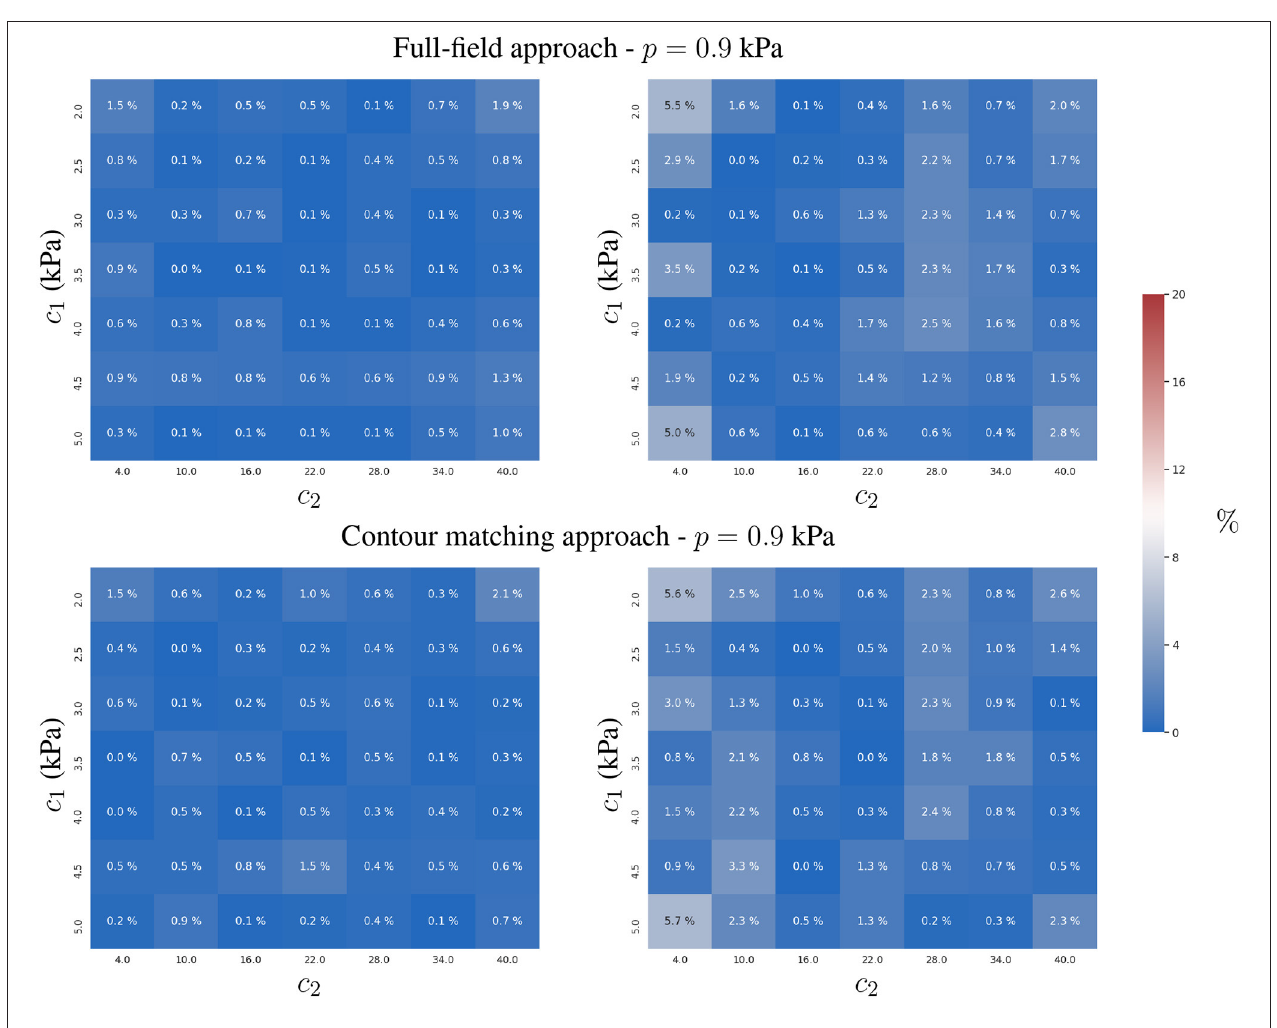
FIGURE 3 | Relative error of the two-parameter estimation. Estimates of the constitutive parameters c 1 (left) and c 2 (right) are presented using the full-field tracking and contour matching approaches with a load of p = 0.9 kPa in the absence of noise in the observations. For details of estimations for other loads, refer to the Supplementary Material